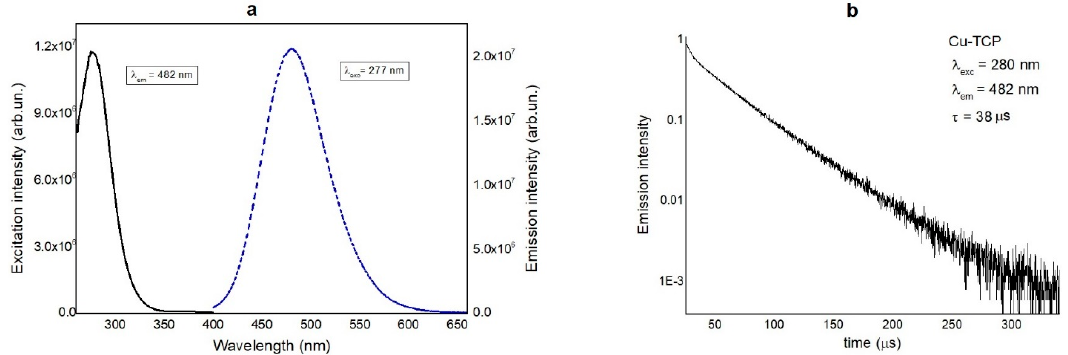
Figure 8. Mn β -TCP structure: Emission / excitation spectra ( a ) and decay time ( b ).